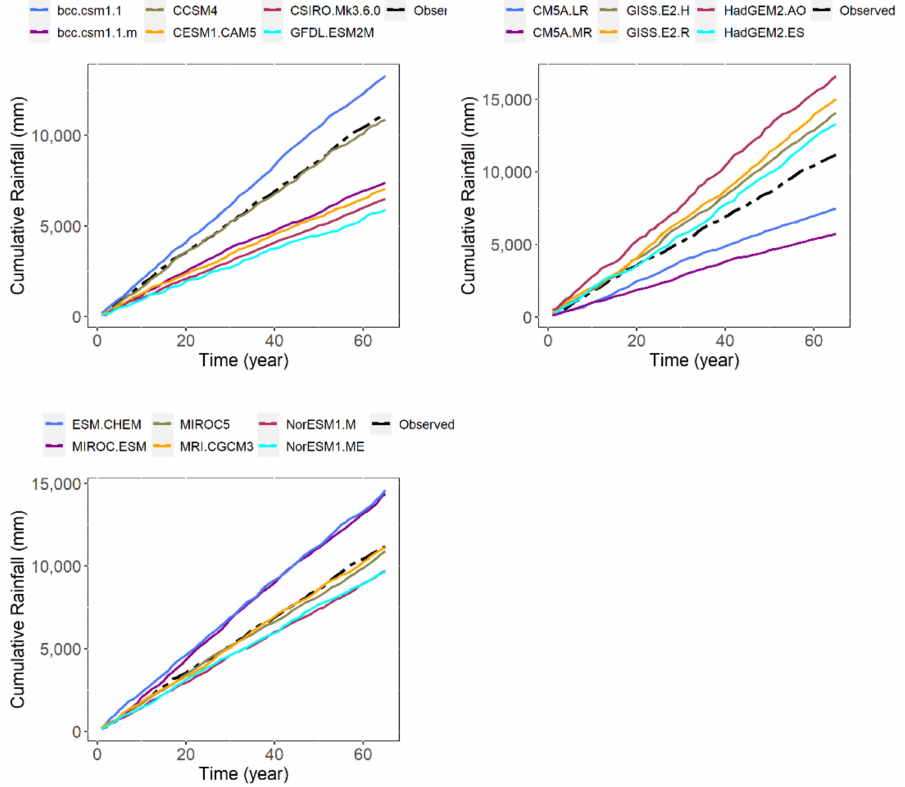
Figure 8. Cumulative areal average of observed and modelled precipitation in